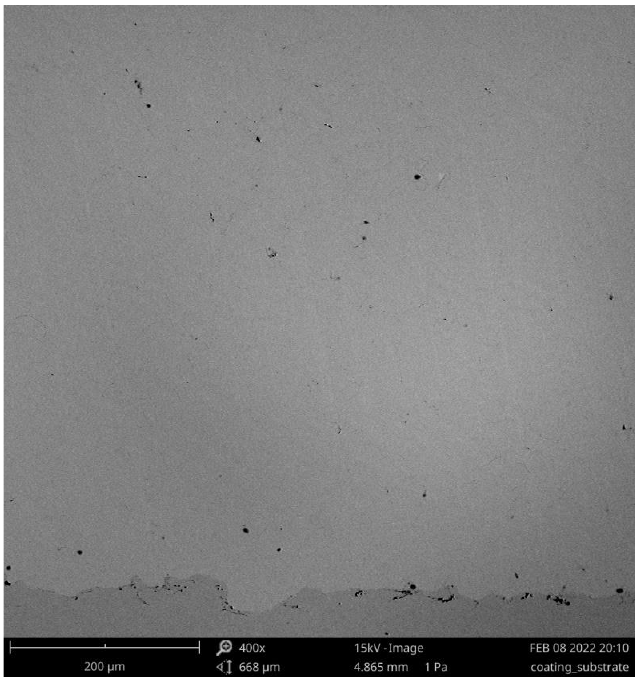
Figure 3. Coating and interface aspect.